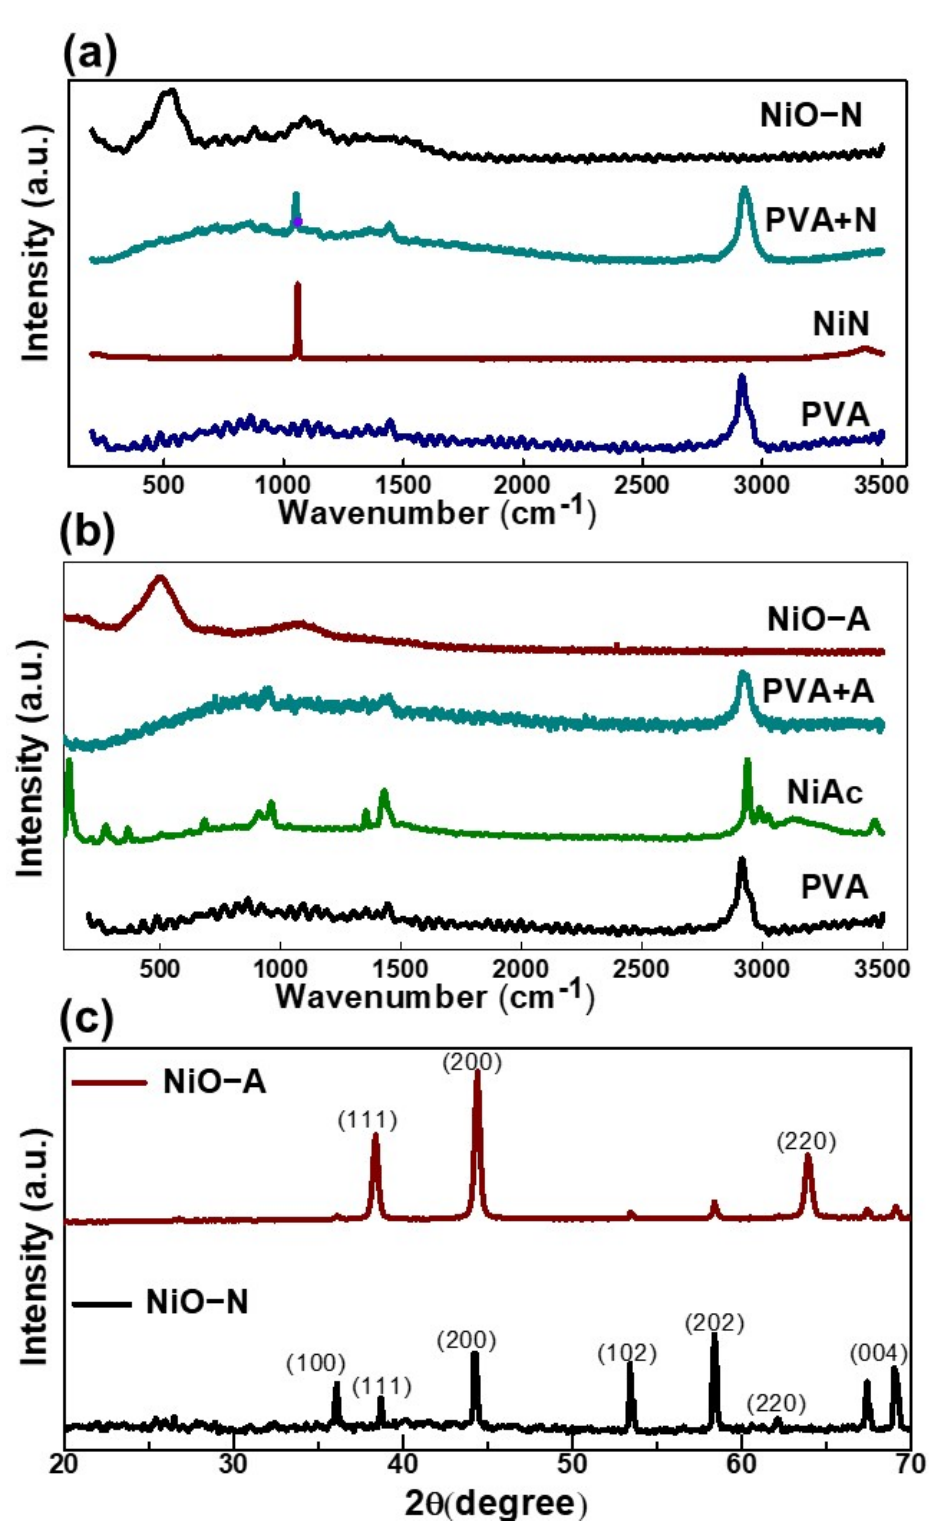
Figure 3. ( a , b ) Raman spectra of NiO-N and NiO-A before and after calcination, and their initial components. ( c ) XRD spectra of NiO-N and NiO-A.